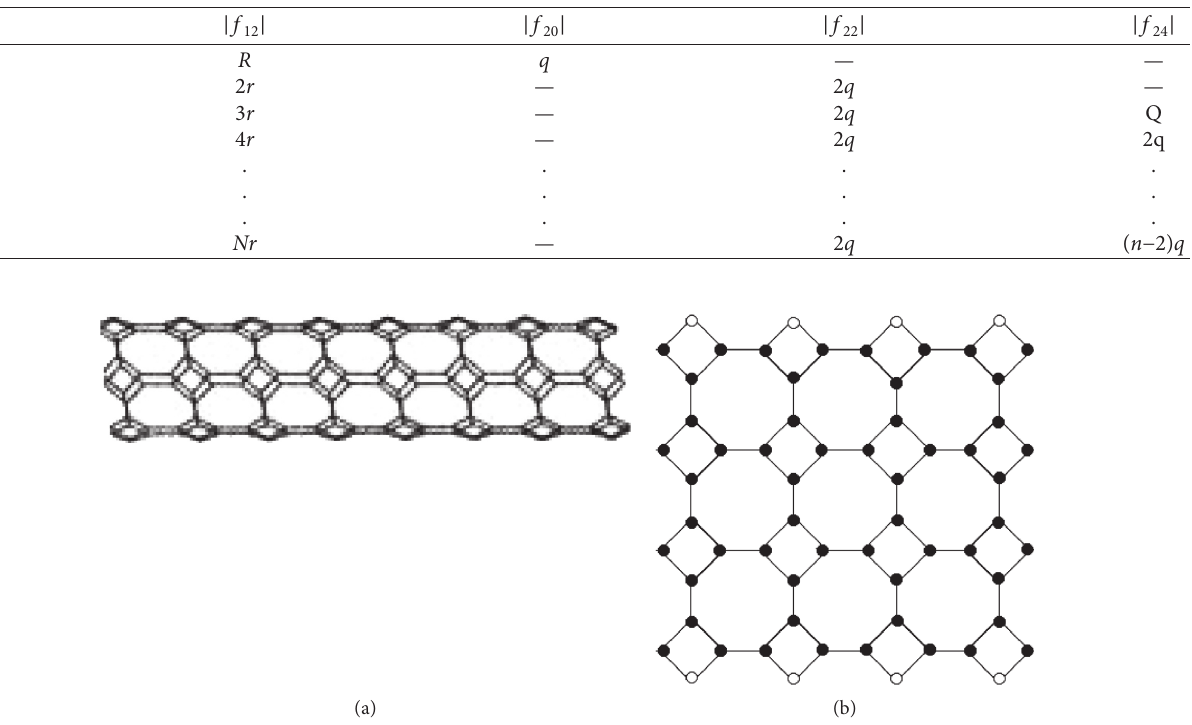
Figure 2: (a) 3D nanotube TUC Table 2: Numbers of f